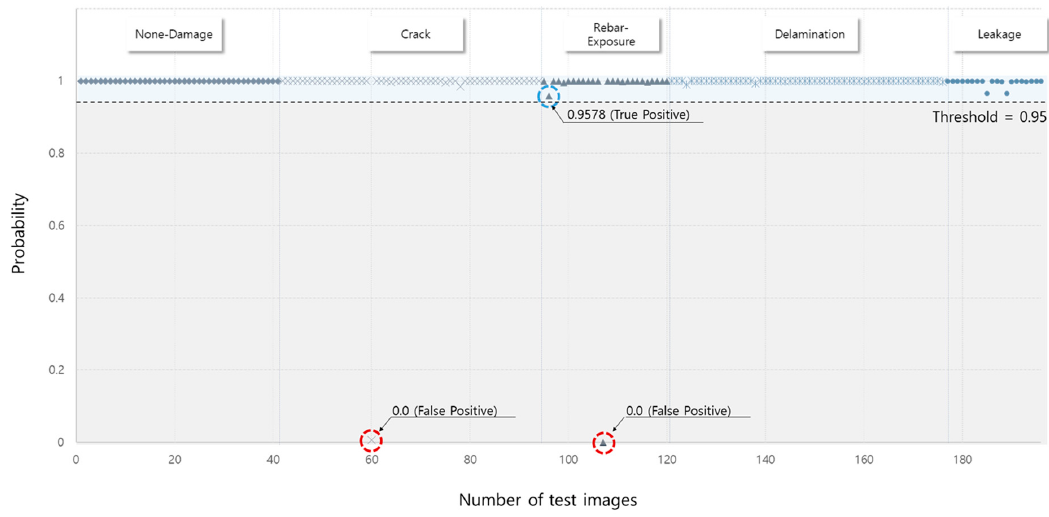
Figure 8. Prediction probability distribution of proposed model.